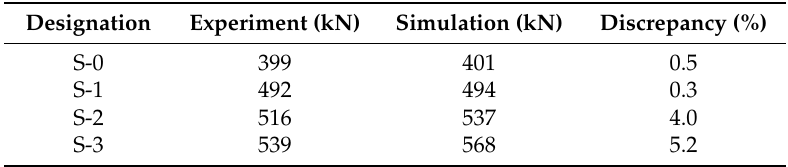
Figure 16. Comparison of lateral deformation curves. Table 3. Comparison of load capacity.